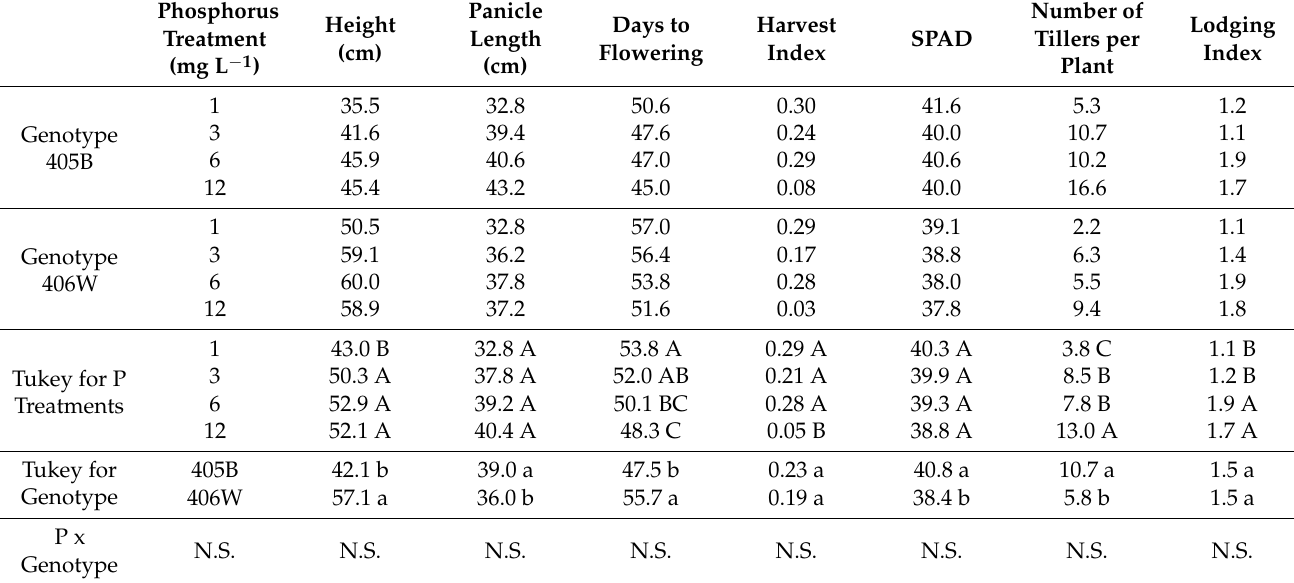
Table 1. Effect of P fertigation levels on growth parameters in the winter pot experiment. Different letters represent significant (<0.05) differences for main effects. Upper case letters next to the values in the 3rd row represent the results of the Tukey test for nutrient concentration averaged across genotypes, and lower case letters next to the values in the 4th row represent the results of the Student- t test for the two different genotypes.